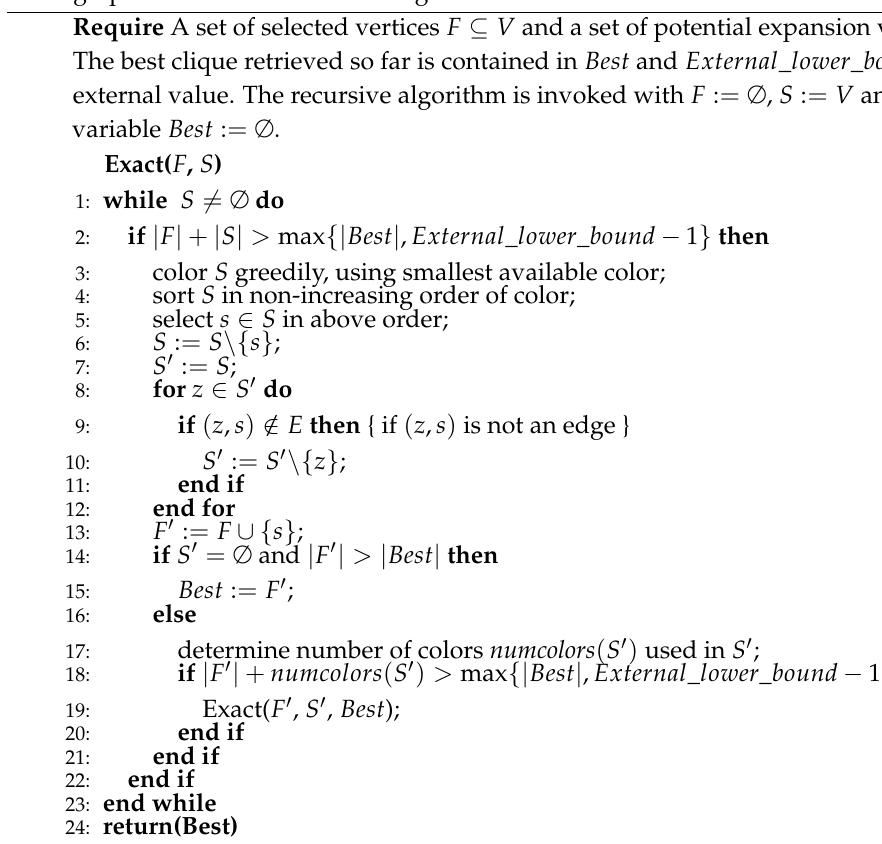
Algorithm 1: The exact algorithm “C&P with ordered local coloring” applied to a graph or subgraph with vertex set V and edge set E